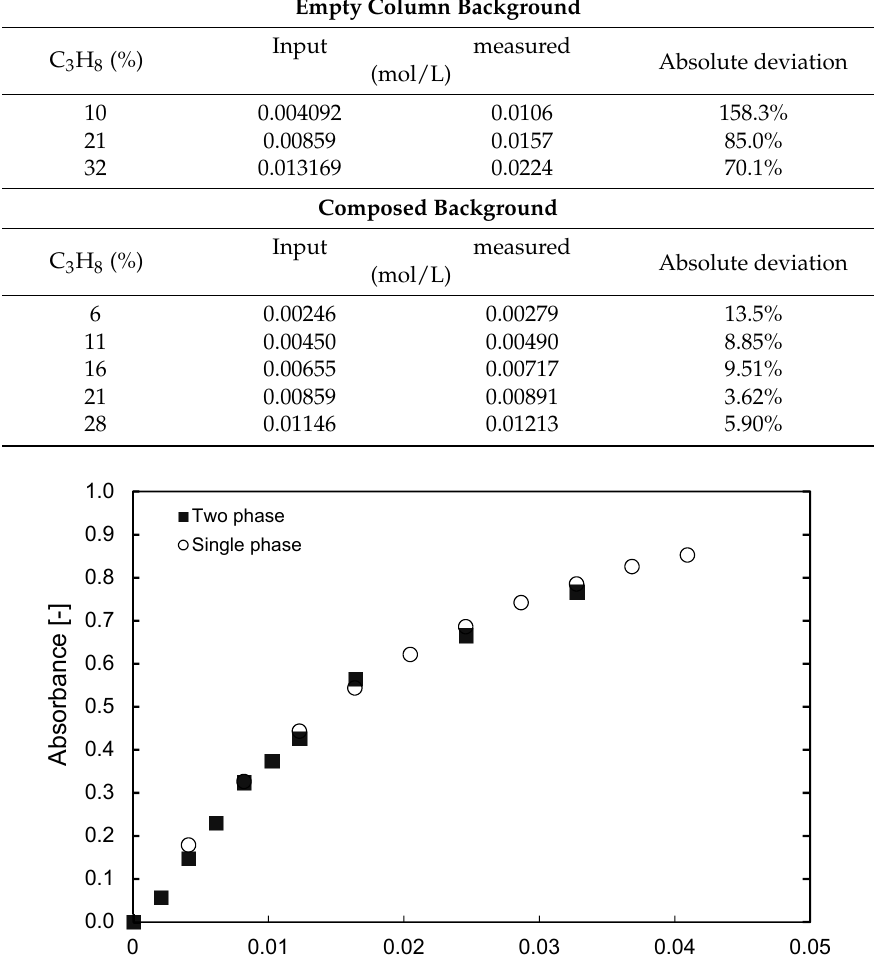
Table 2. Measurement of the error for two phase system with different backgrounds.